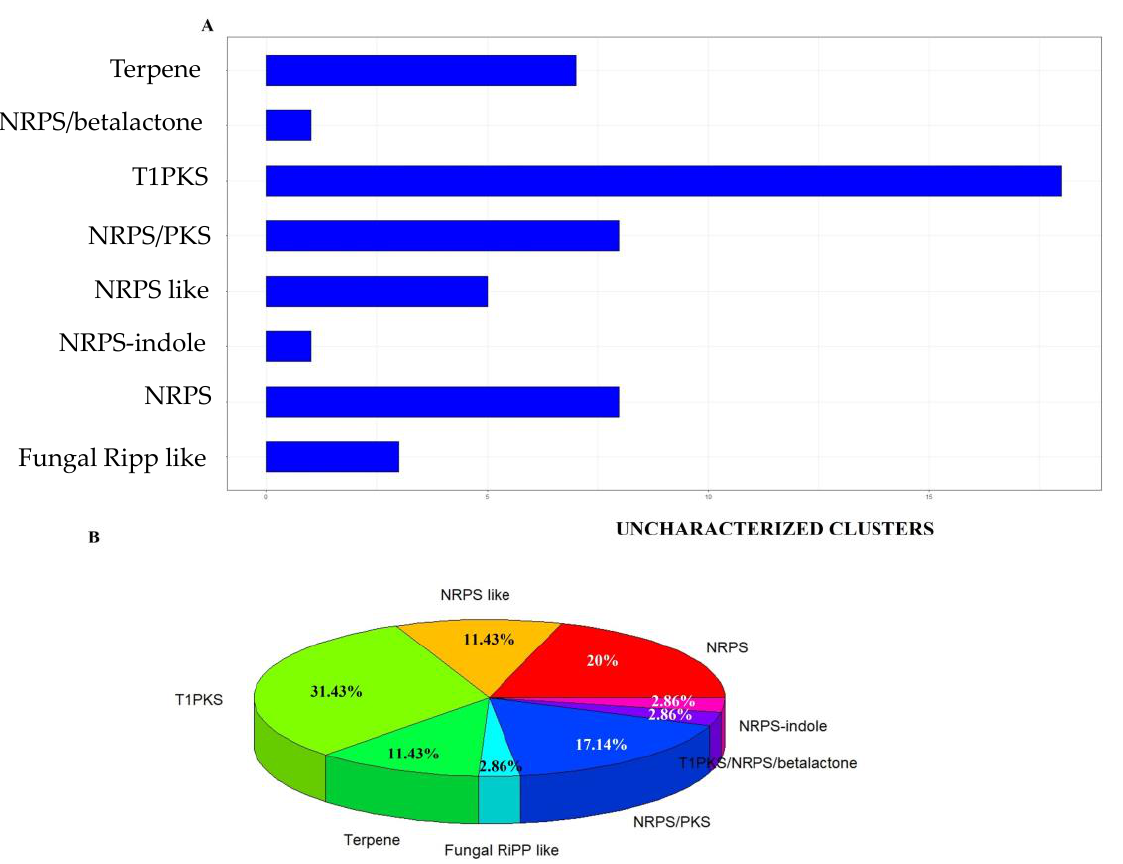
Figure 2. Biosynthetic gene clusters of Trichoderma endophyticum MMSR85. ( A ) Identification and number of biosynthetic gene clusters in Trichoderma endophyticum MMSRG85 according to their secondary metabolite class: NRPSs (nonribosomal peptide synthetases), NRPS-like (NRPS-like frag- ment), T1PKS (type I polyketide synthetase), terpene, fungal RiPP-like (fungal, unspecified, riboso-